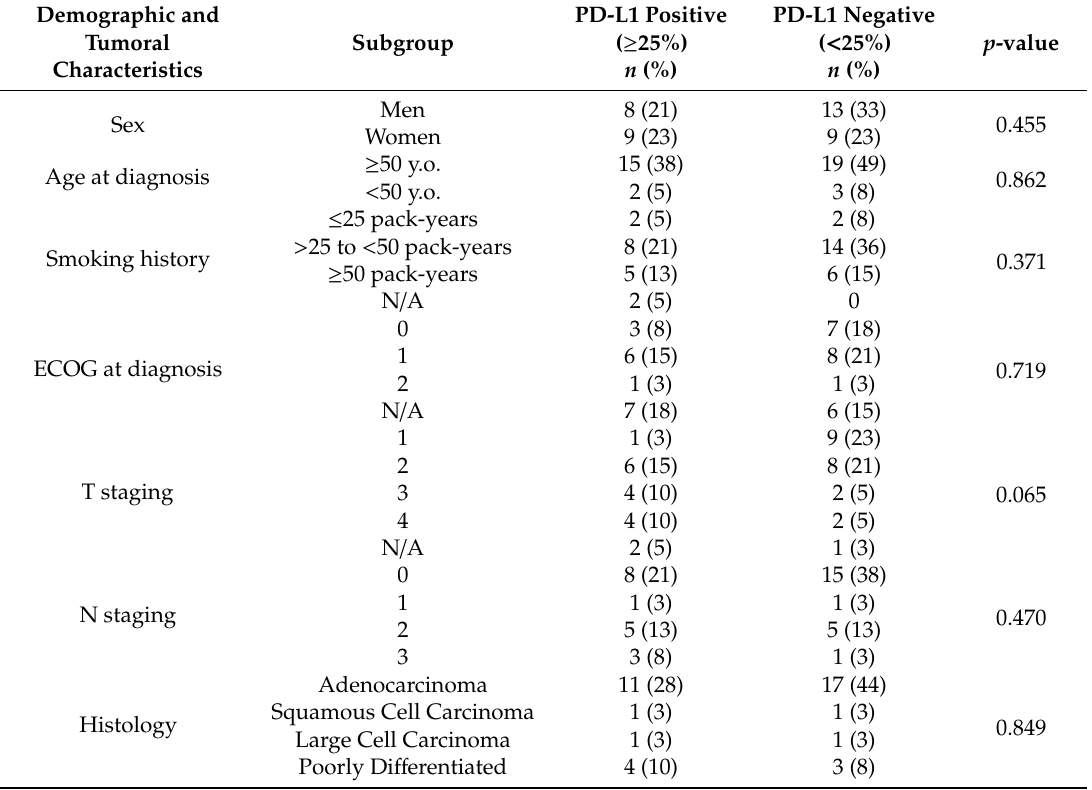
Table 3. PD-L1 status and clinical characteristics of subgroup of 39 patients.